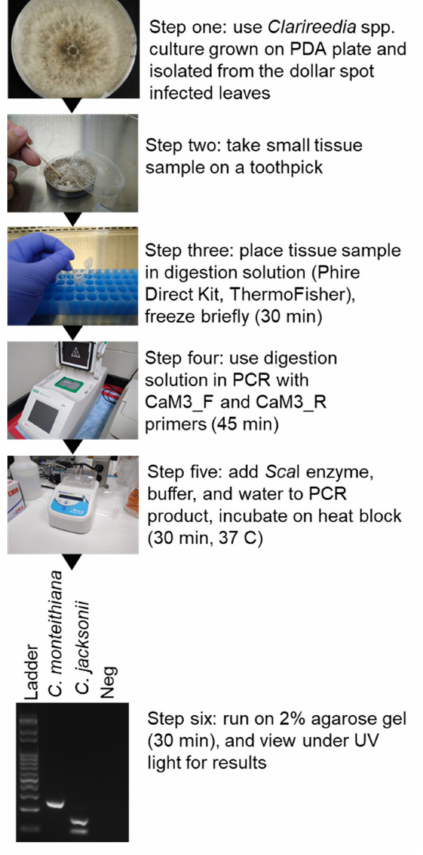
Figure 4. Step by step of modified CAPS assay using direct PCR to detect specifically C. jacksonii and C. monteithiana . The estimated time for this protocol was 3